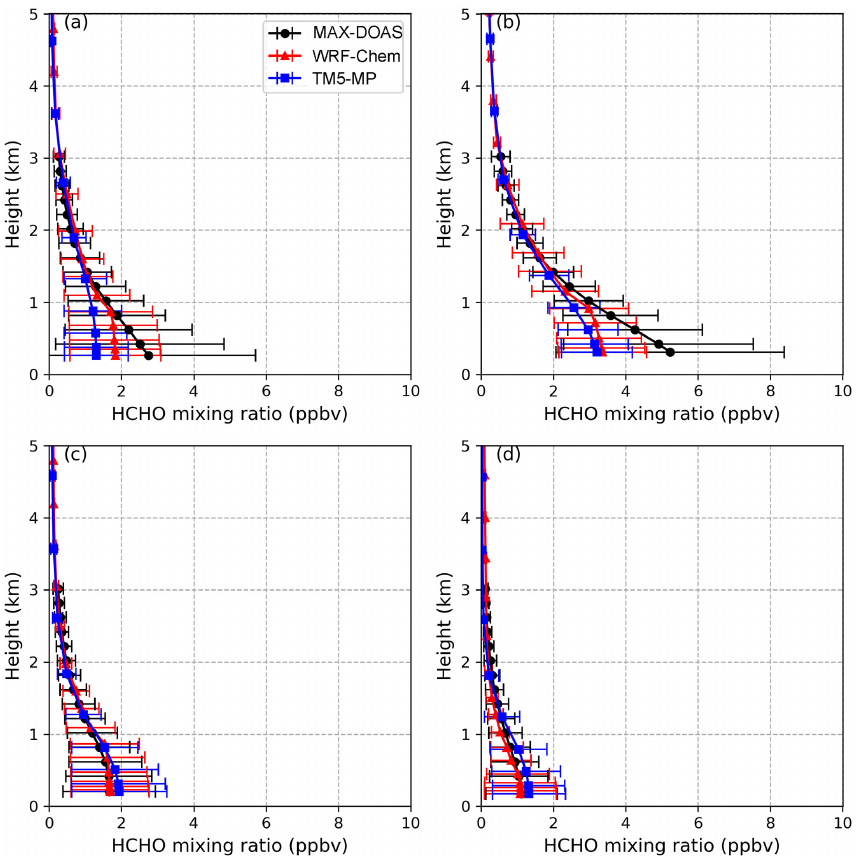
Figure 8. Seasonal average of vertical HCHO profiles obtained from MAX-DOAS, WRF-Chem and the TM5-MP model in spring (a) , summer (b) , autumn (c) and winter (d) at the UCAS site. The error bars represent 1 σ standard deviation of variation.